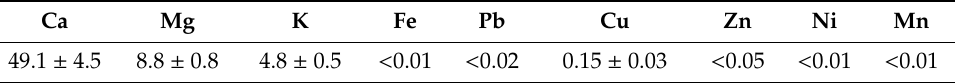
Table 3. Concentrations of selected metal cations in drinking water samples (mg L − 1 ).